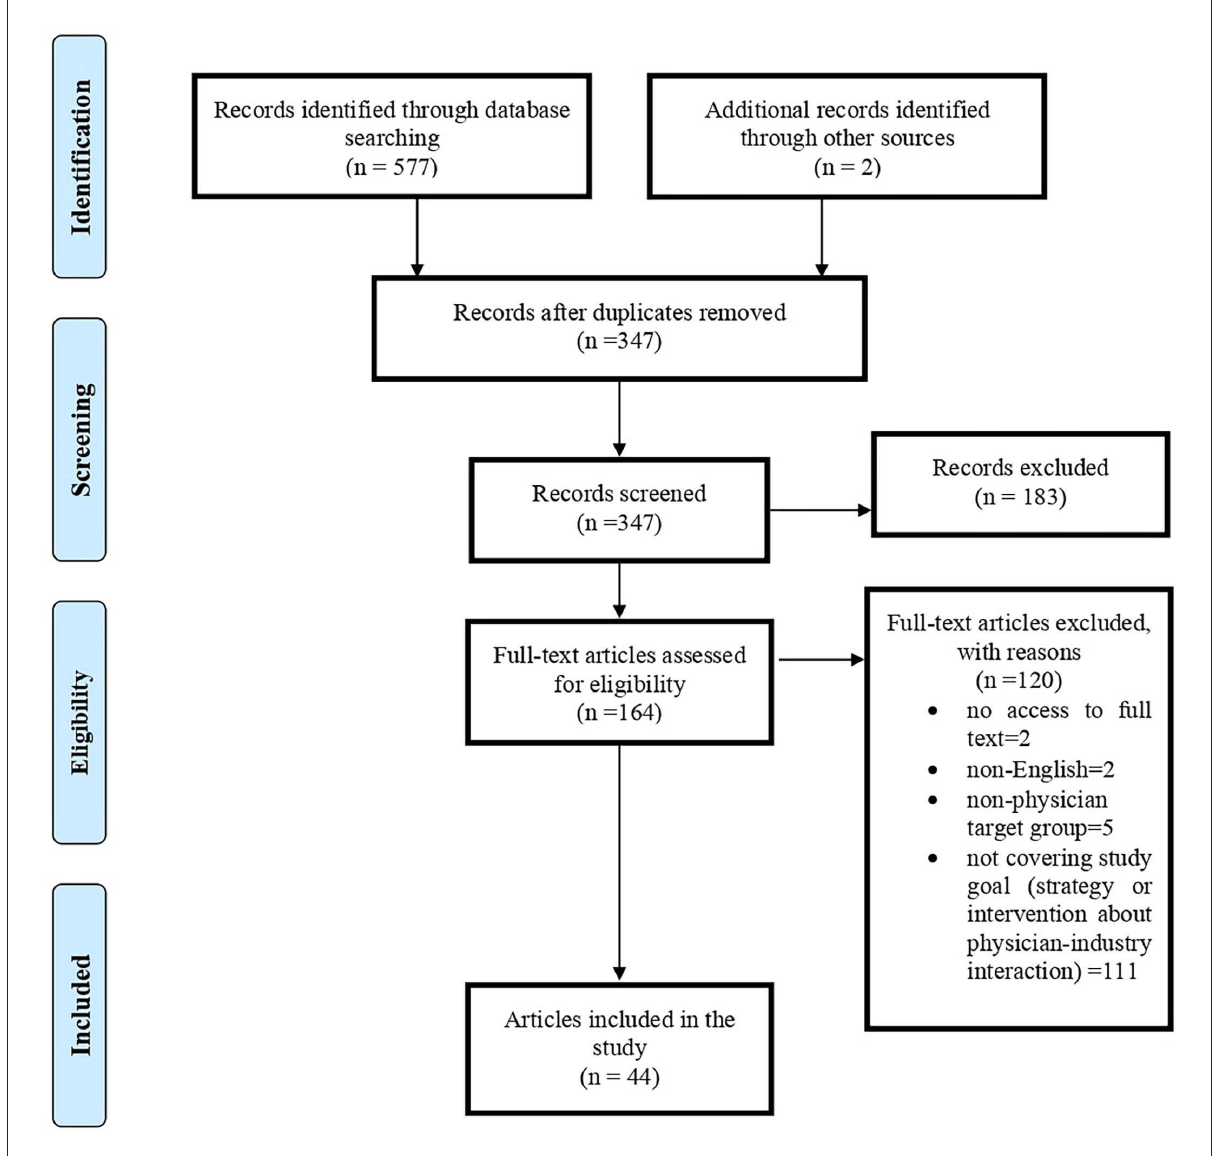
FIGURE1 PRISMA flowchart of systematic literature